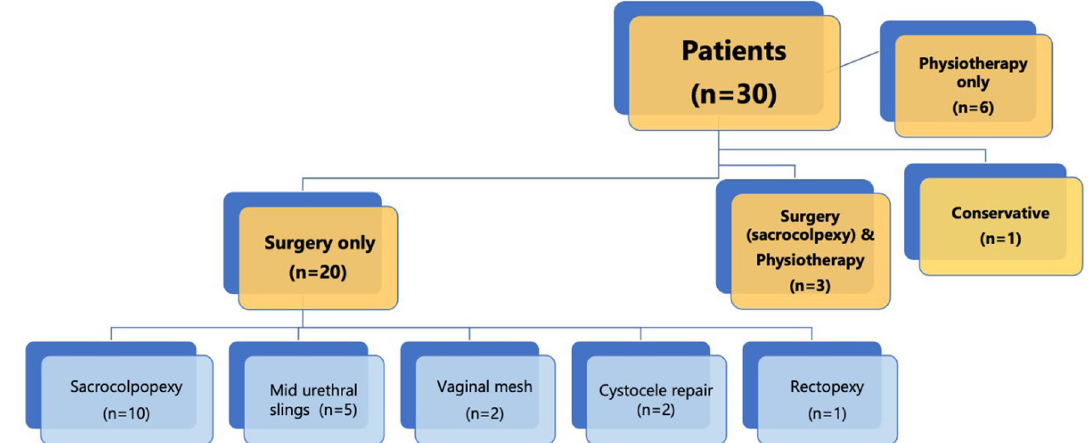
Fig. 1 Diagram illustrating the spectrum of patient according to their